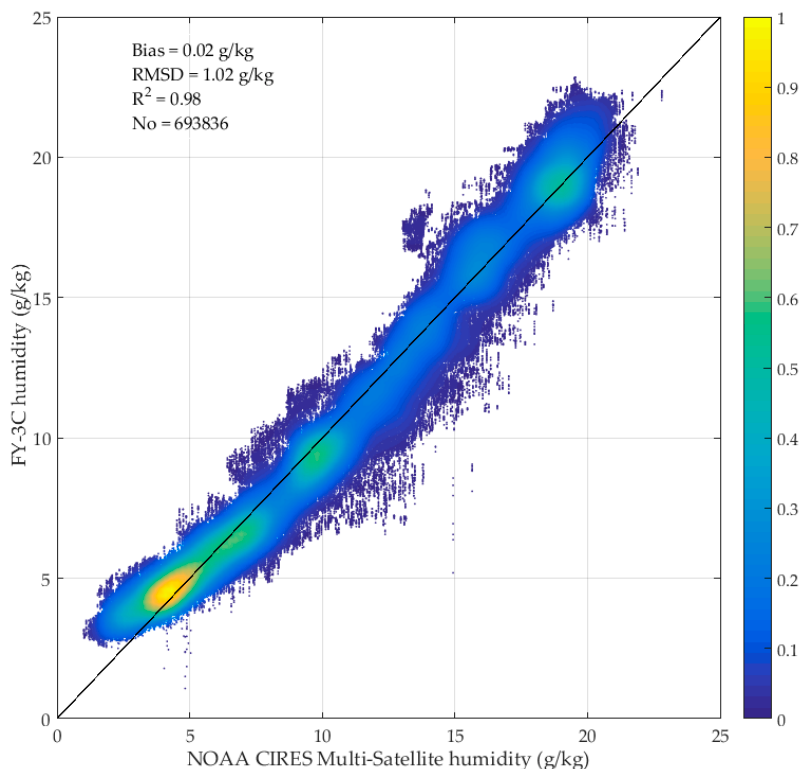
Figure 11. Results of the comparison between NOAA CIRES Multi-Satellite Humidity and FY-3C humidity on 6 October 2014. Color depth indicates the density of data.